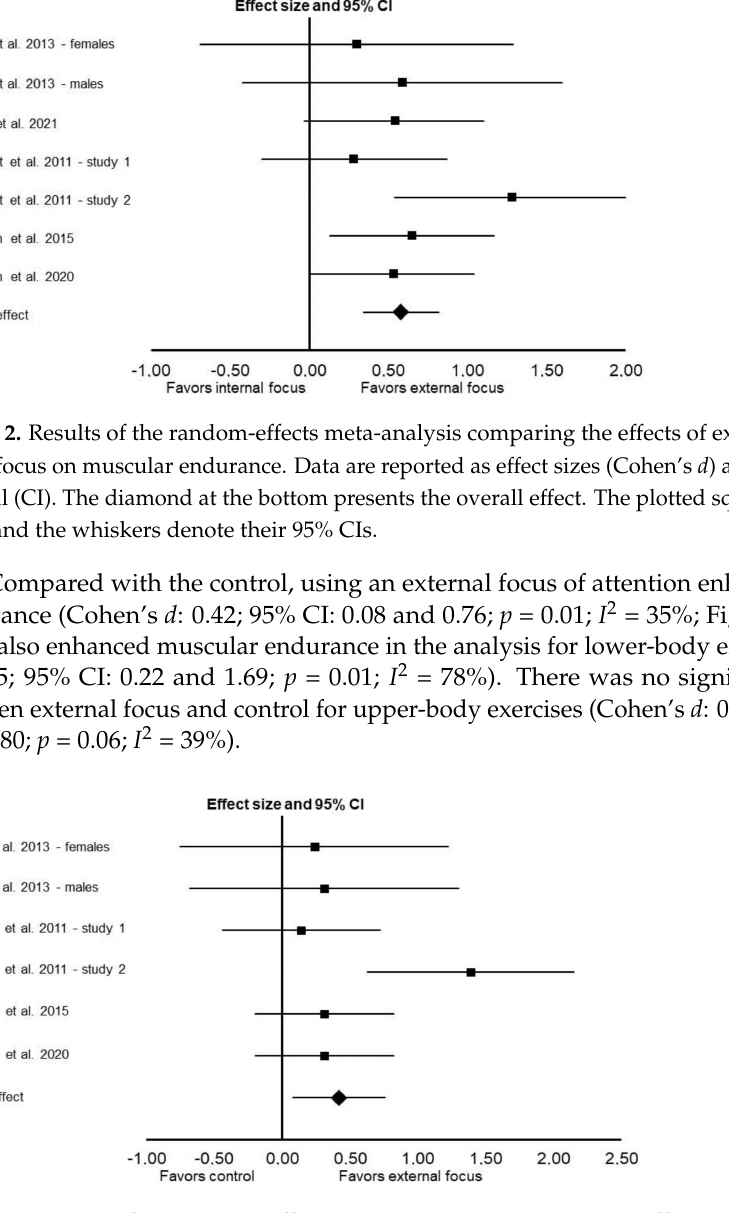
Figure 3. Results of the random-effects meta-analysis comparing the effects of external focus vs. control on muscular endurance. Data are reported as effect sizes (Cohen’s d ) and 95% confidence interval (CI). The diamond at the bottom presents the overall effect. The plotted squares denote effect sizes, and the whiskers denote their 95%